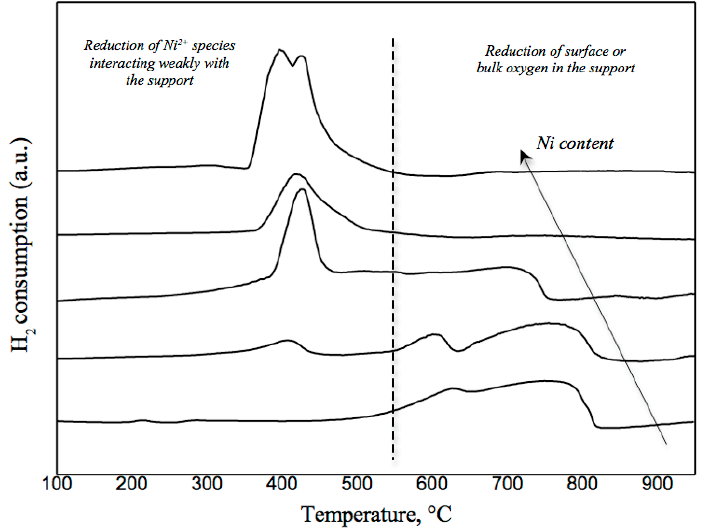
Figure 5. Qualitative TPR ‐ H 2 profiles for impregnated Ni ‐ supported on doped ceria. Takano et al. recently investigated a 50 wt % Ni/(Zr + Ca) catalyst (molar ratios 0.125–0.333)